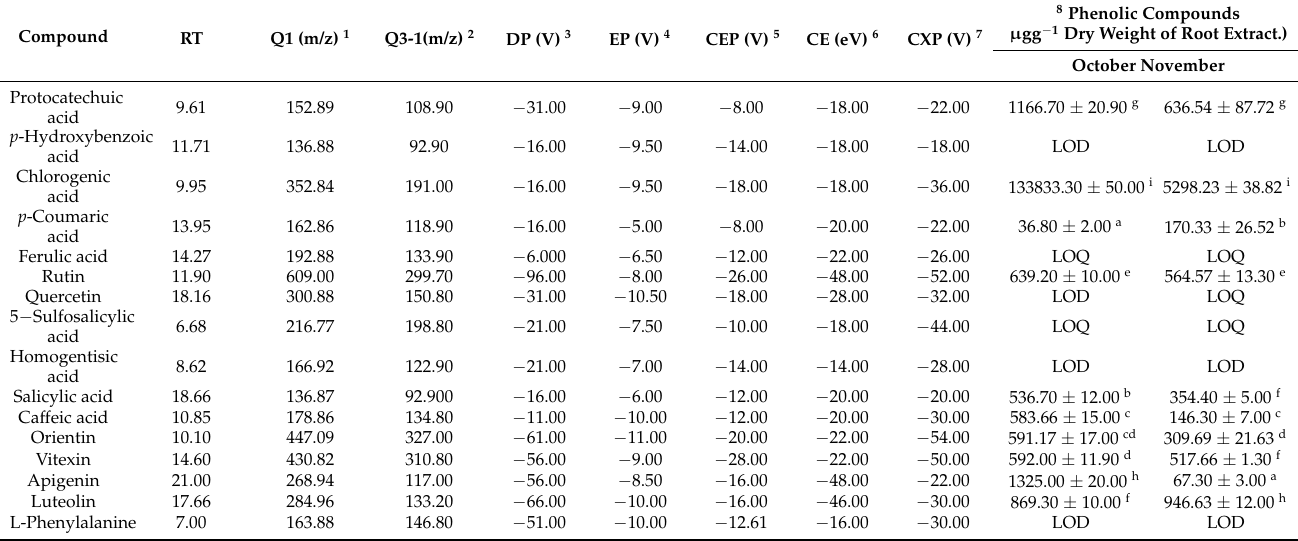
Table 1. LC-MS/MS parameters of the phenolic compound quantitative